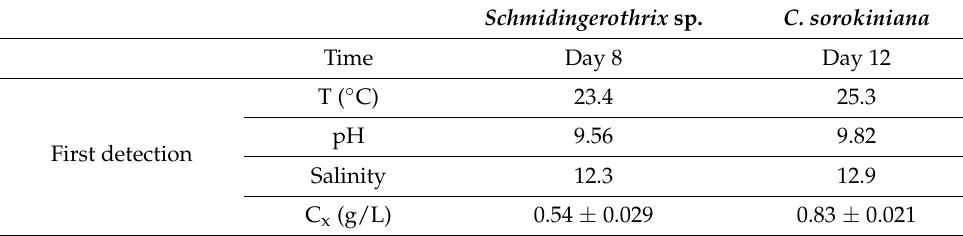
Table A3. Evolution in terms of presence/absence of the ciliate Schmidingerothrix sp. and the chlorophyte C. sorokiniana in the A. platensis BEA 1257B culture in the 8000 L raceway pond inside the greenhouse. Time when the mild treatments i.e., CO 2 stop, batch addition of sodium bicarbonate (NaHCO 3 ) in the amount of 4 g per liter of culture in order to rise alkalinity, and batch addition of ammonium sulphate ((NH 4 ) 2 SO 4 ) at 1 mM concentration were applied to the culture is also reported. Schmidingerothrix